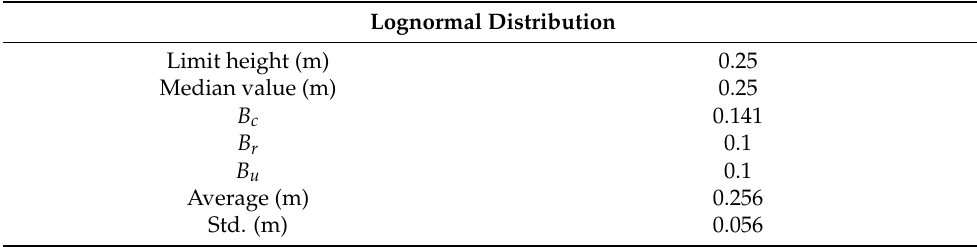
Figure 21. Fragility curve estimated for the MCC room in NPPs 3 and 4. Table 15. Parameters of lognormal distribution.